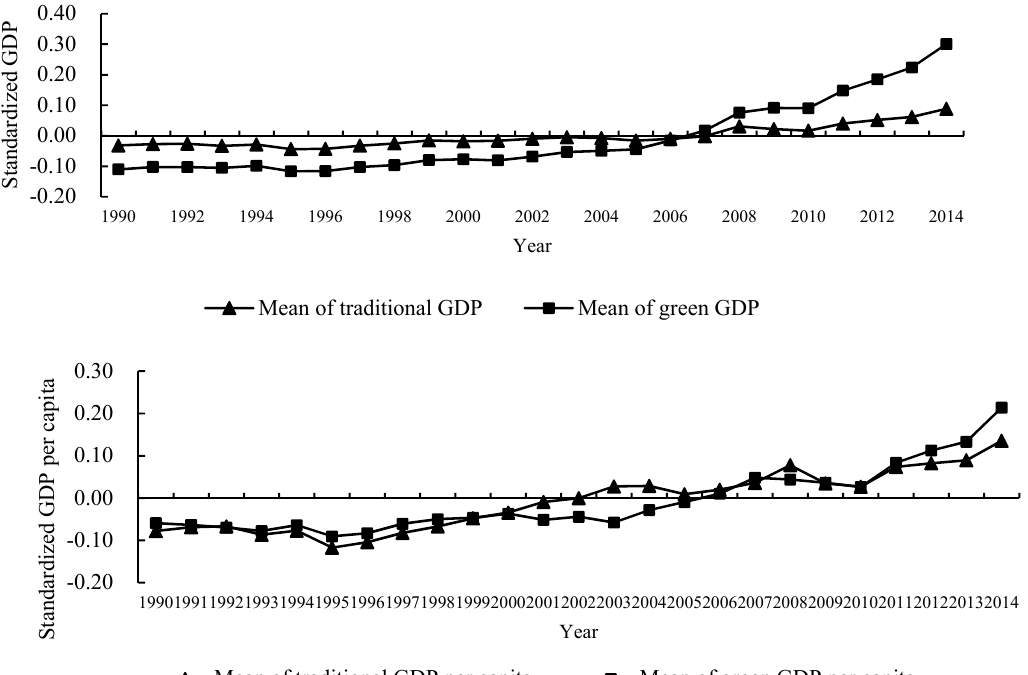
Figure 1. Means of standardized traditional GDP and green GDP over the period 1990-2014.